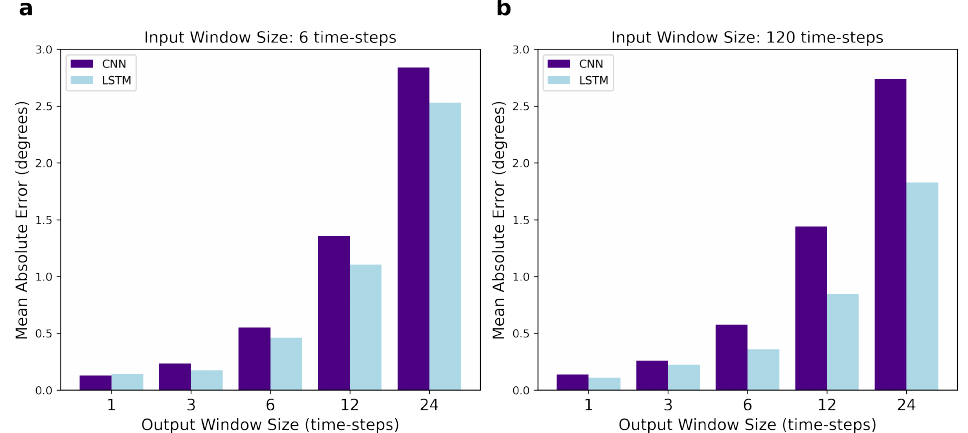
Figure 5. Comparison of the performance of the CNN and LSTM network, measured by MAE, for varying output window sizes. In ( a ), the input size is fixed at 6 time-steps, while in ( b ) the input is fixed at 120